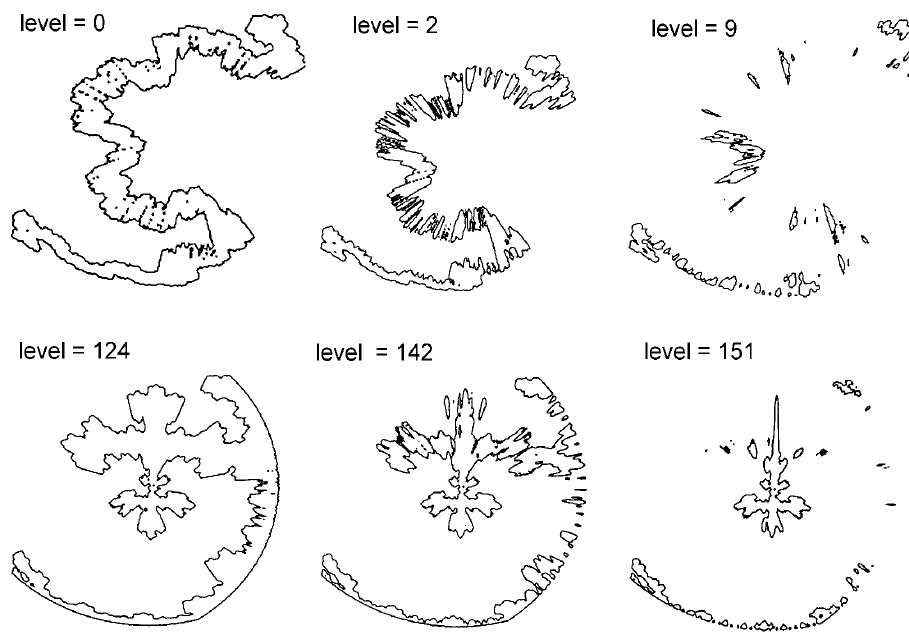
Fig. 8. Examples of isolines used in box-counting calculations of the spectra presented in Fig. 7: (a) solid line from Fig. 7a; (b) solid line from Fig.